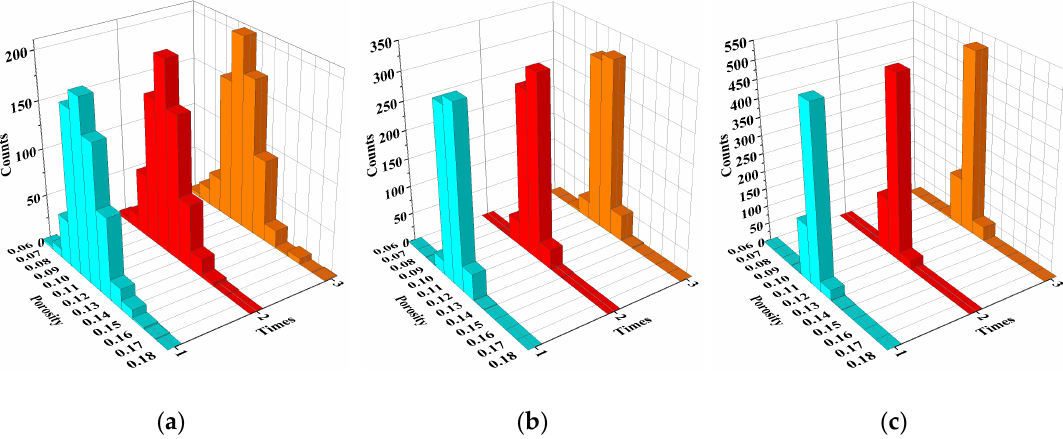
Figure 2. The initial porosity distribution at different shape parameters: ( a ) k w = 2; ( b ) k w = 5; ( c ) k w = 8.